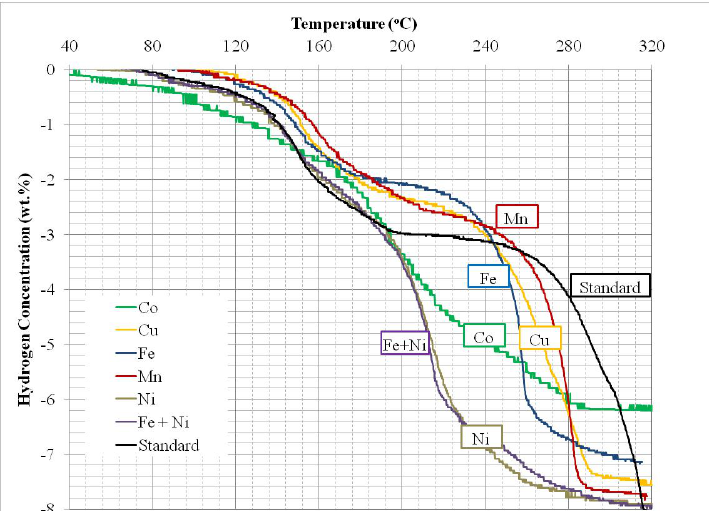
Figure 4. Ramping kinetic measurements of LiBNH + n MgH nano catalysts such as Mn, Fe, Co, Cu, Ni and Fe +